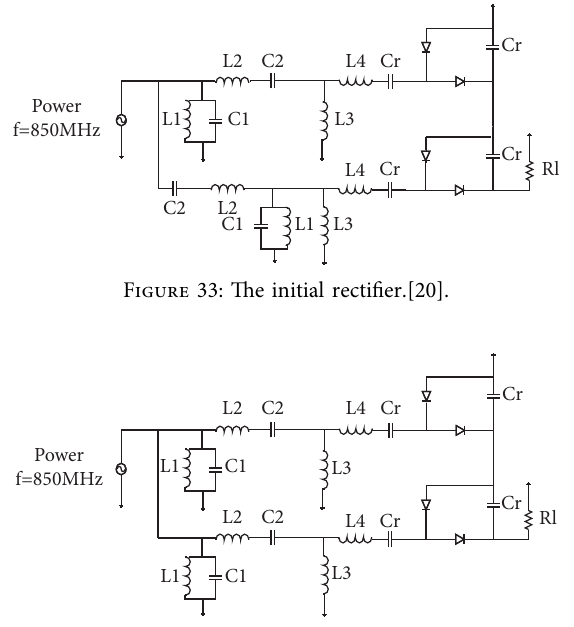
Figure 34: Rectifer with the frst branch of RCN.